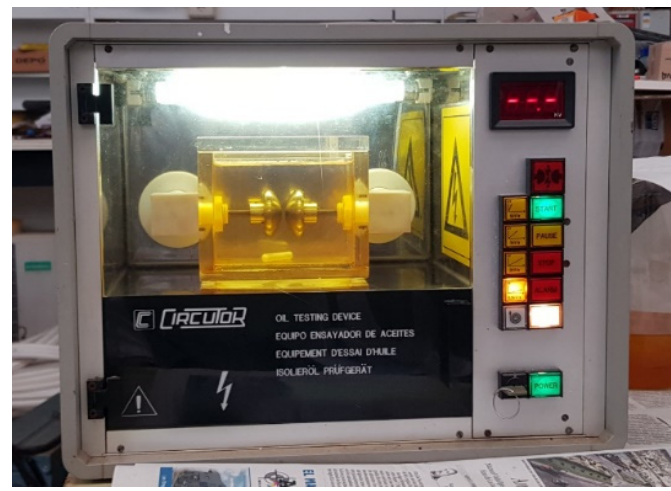
( d ) Figure 19. Error histograms: ( a ) comparison C1; ( b ) comparison C4; ( c ) comparison C9; ( d ) compar- ison C12. If the comparisons are grouped following the order {C1, C5, C9}, {C2, C6, C10}, {C3, C7, C11} and {C4, C8, C12}, it is observed, in a generalized way, that increasing the mesh density improves the model for any of the numerical experiments analyzed. Comparing Figures 13, 15 and 17 with Figures 14, 16 and 18, it can also be seen that the voltages in {C3, C7, C11} and {C4, C8, C12} were modeled, in relative terms, much better than the electric fields in {C1, C5, C9} and {C2, C6, C10}. The values of the coefficient of determination (R 2 ) indicate a good fit of the data for all the comparisons except those cases where the mesh was not very dense. The RMSPE, MAPE and PBIAS values are relatively high in the comparison. Nevertheless, all the indi- cators are in the optimal range. Even the largest error value of 0.36% for the RMPSE, as shown in Table 3, is a more than acceptable value. The distribution of the errors, following error theory, conforms to a normal distribu- tion centered on the zero value, as shown in Figure 19. The detailed formulations of the metrics used appear in the Annex. 5. Experimental Setup of Oil Testing Device 5.1. Procedure for Dielectric Strength Test and Kinematic Viscosity of Oil Dielectric oil strength test equipment [17] is known as a spark meter or dielectric oil tester. The equipment is in the form of a closed metal cabinet with a handle to facilitate its transport, as shown in Figure 20. Inside is the test cell, where the oil sample to be tested is